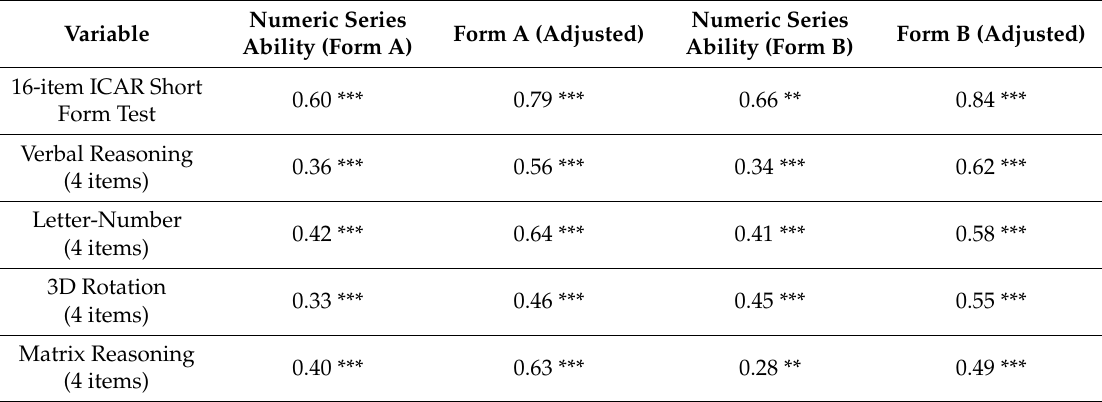
Table 10. Correlations between the factor scores of the number series items and the 16-item International Cognitive Ability Resource short form overall and individual item